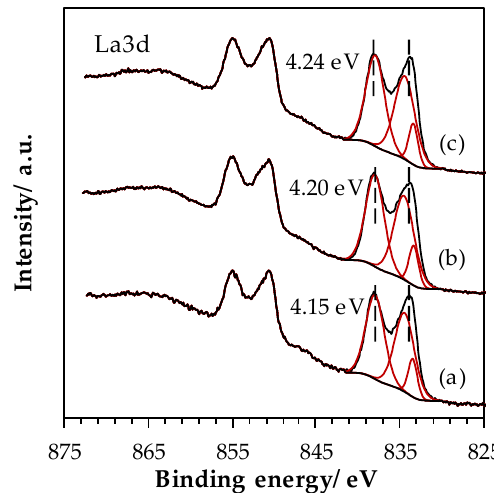
Figure A1. High-resolution spectra of La 3d and Mn 2p core level spectra for LaMnO 3.15 samples: (a) SSR, solid state reaction; (b) HEBM, high-energy ball milling; (c) LEBM, low-energy ball milling.